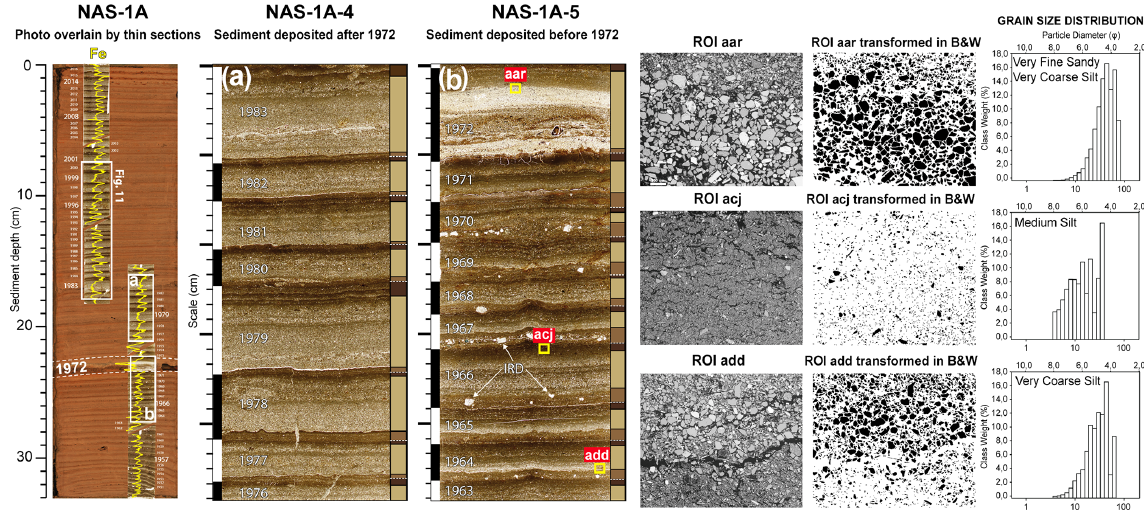
Figure 5. (Left) Photo of core NAS-1A overlain by a thin section image and Fe relative intensity profile (yellow lines). The 1972 marker layer is highlighted by the white dashed lines. Thin section images showing the sedimentary structure of varves deposited (b) before and (a) after the 1972 marker bed. Varve boundaries are represented by the vertical black and white bars (left y axis). Varve layers are delimited by the medium brown (early spring layer), pale brown (detrital layer) and dark brown (autumn and winter layer) bars (right y axis). Typical ice-rafted debris (IRD) is shown by the white arrows in panel (b) . (Right) BSE images of three ROIs transformed in black and white and their associated particle size distribution (aar represents the 1972 marker layer, acj represents a typical autumn and winter layer, and add represents the base of a typical detrital layer); see the yellow squares in panel (b) for the ROI